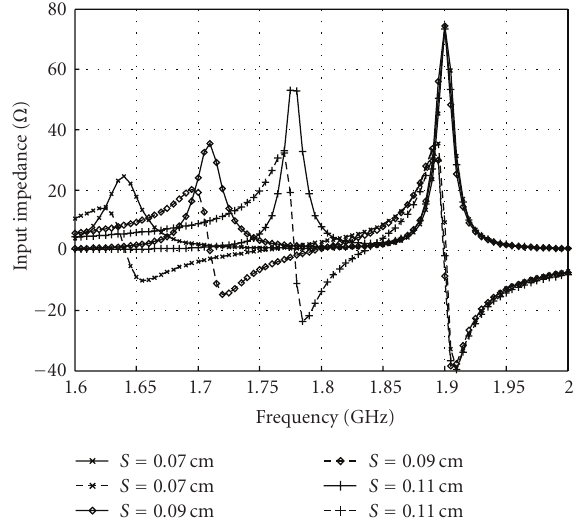
Figure 4: Variation of input impedance with frequency for di ff erent gap length at C = 3.001